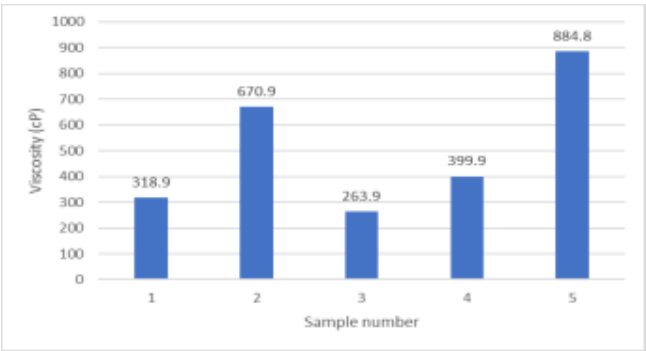
Figure 3: Viscosity of the emulsion based on formulation